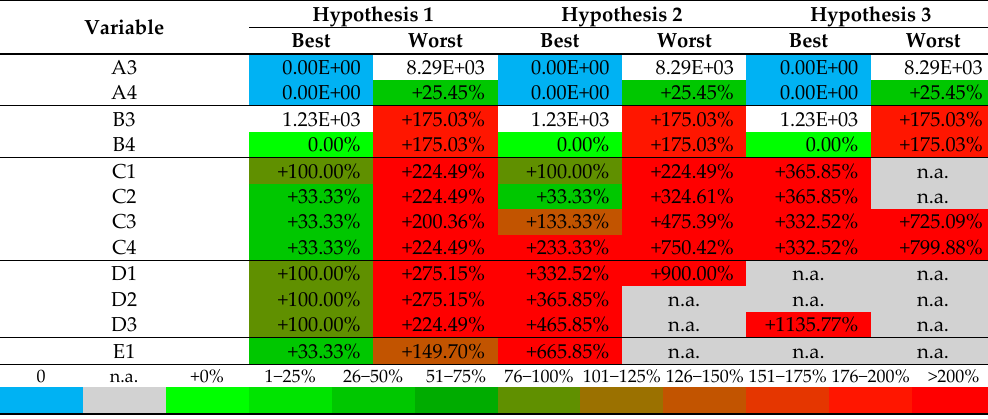
Energies 2019 , 12 , x FOR PEER REVIEW 11 of 43 Table 6. Increase of emissions according to the climatic zone for the best and worst set ups. Hypothesis 1 Hypothesis 2 Hypothesis 3 Variable